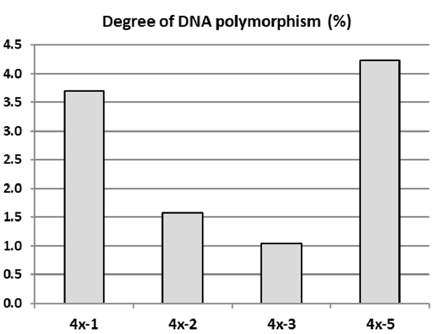
Figure 5. DNA polymorphism of apple tetraploid clones derived from the ‘Free Redstar’ cultivar determined with amplified fragment length polymorphism (AFLP) markers.